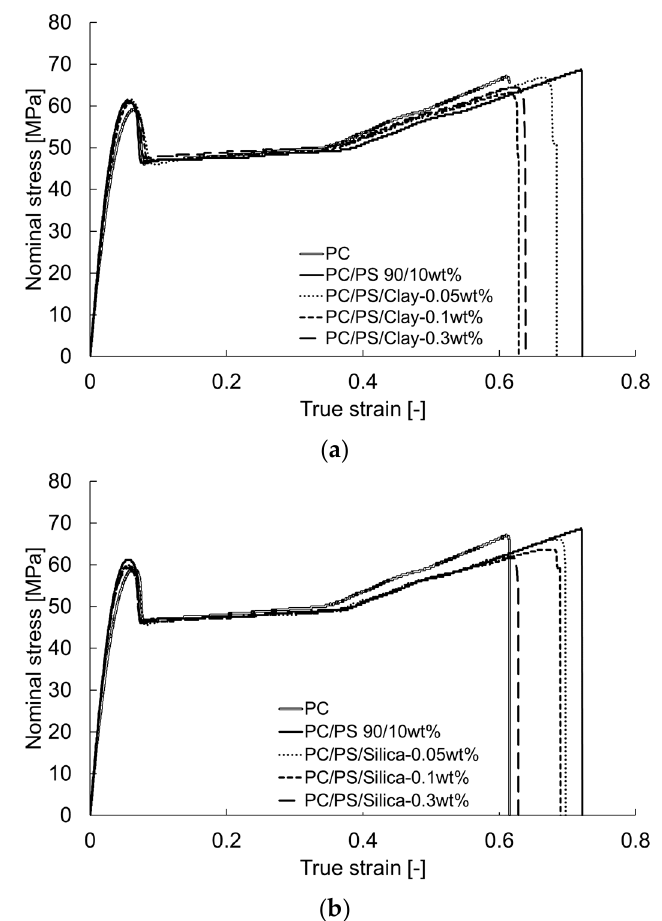
Figure 6. Nominal stress–true strain curves of PC/PS/nano-filler composites: ( a ) PC/PS/clay; ( b )